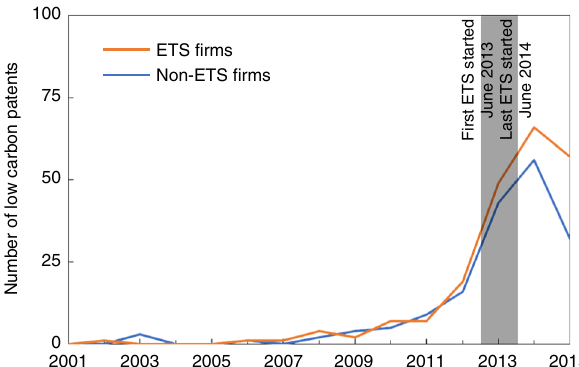
Fig. 2 The number of low-carbon patenting by matched ETS and non-ETS fi rms. ETS and non-ETS fi rms had similar trends of low-carbon patenting before the ETS started, and diverged afterwards. The gray area marks the period from the fi rst program being started in June 2013 to the last program